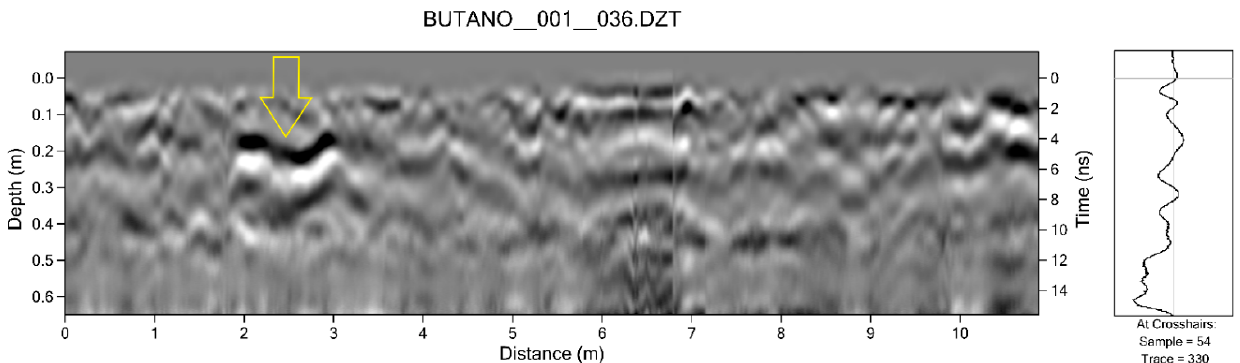
Figure 5. Ground-penetrating radar transect for grid 1 and anomaly identified in slice eight (Figure 4) marked with an arrow. Radargram profile 36 shows a distinctive feature at a depth of ~20 cm, corresponding to slice 8 (Figure 4).